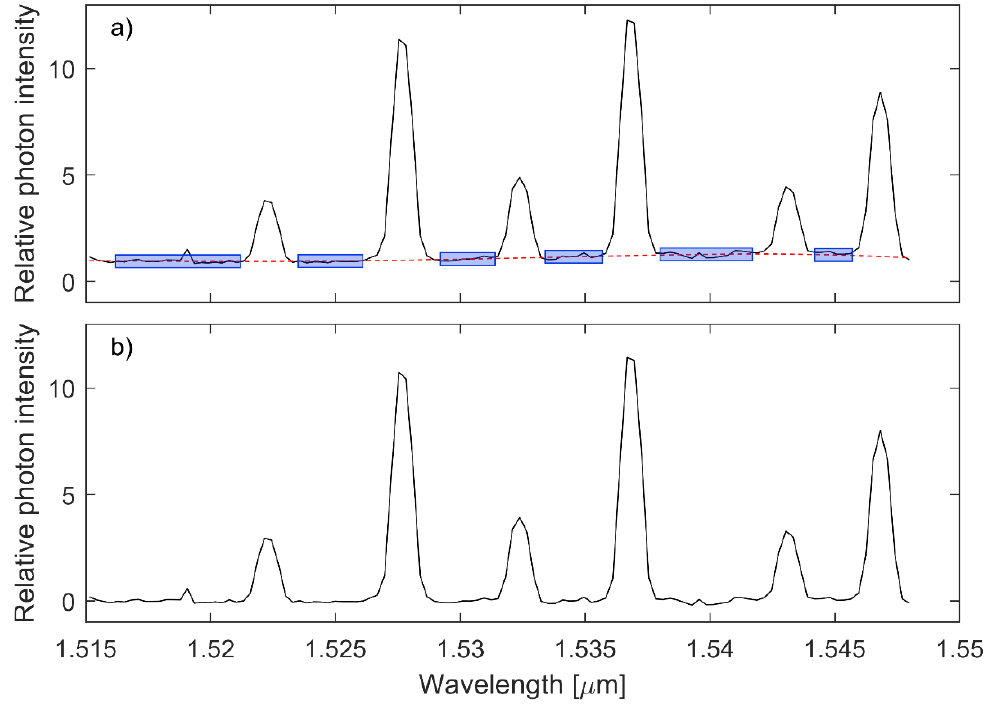
Figure 1. Example of the background fit and subtraction on the P-branch of the (3,1) transition. ( a ) Fit to the background. The clean areas between the lines are marked in blue, and the fit of a fourth-order polynomial to these areas is shown as a red dashed line. ( b ) The same spectrum with the background subtracted.